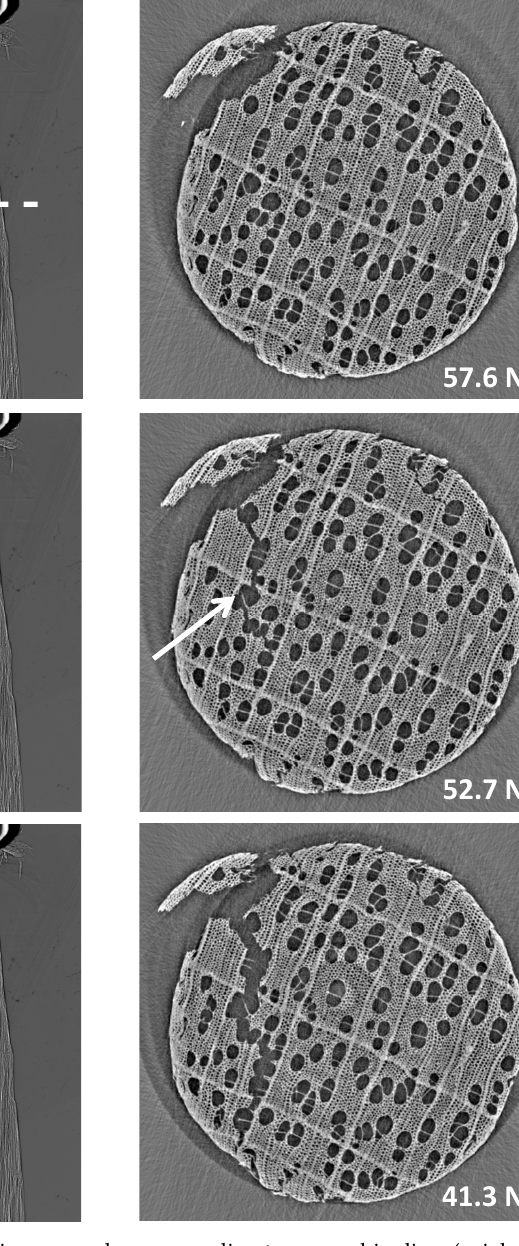
Figure 4. Combination of radiographic images and corresponding tomographic slices (axial, see ( a ) for position of slice) of a force series showing a wood sample under axial load (the pusher is visible as well in the radiographs and the limit of the field-of-view in the lower left corner): Similar to Figure 3 (nominal) force values were measured via the force sensor in the head of “axis